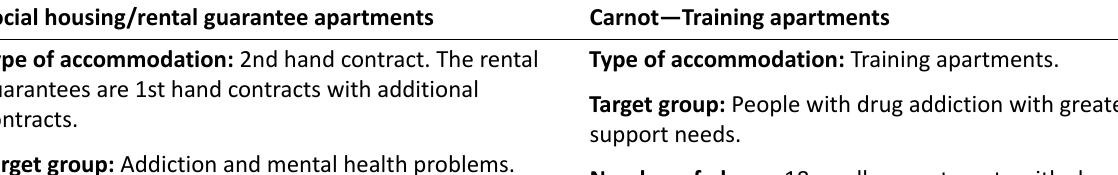
Table 2. The Social Housing Programme in Helsingborg 2017. Social housing/rental guarantee apartments Carnot—Training